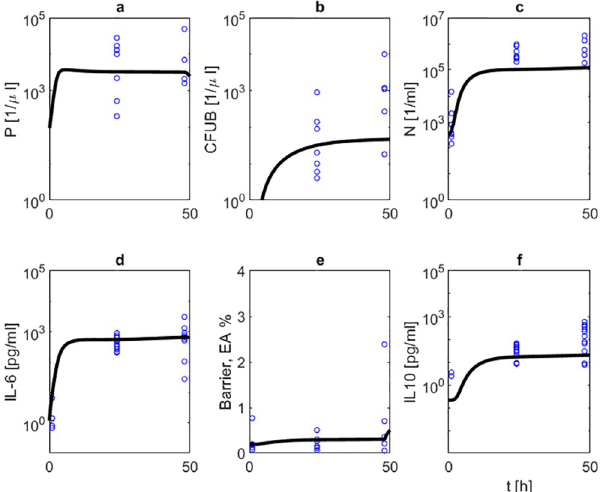
Fig 8. (Treatment with 20 mg/kg NOX-D19). We compare results of model simulation (solid black curve) with data under 20 mg/kg NOX-D19 treatment. Time series of pneumococcal population in BAL (a) and blood (b), neutrophils in BAL (c), IL-6 in BALF (d), barrier function (e) and IL-10 in BALF (f) are displayed. Circles represent data points [2]. NOX-D19 is applied 0 and 24 hours after infection. NOX-D19 alone is insufficient to eradicate the disease but stabilizes the barrier